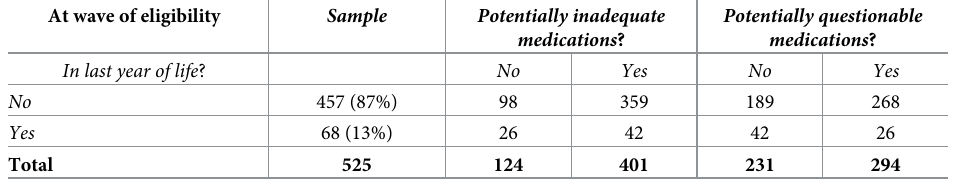
Table 2. Outcome data in the analytic sample ( n = 525).